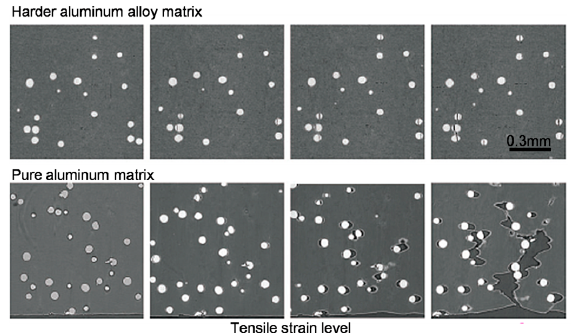
Figure 3. Reconstructed tomographic slices of same region at different strain levels in two model composites (aluminum matrix composites reinforced by 4 vol.% of ZrO 2 /SiO 2 ) observed by in-situ SR- μ CT. The tensile direction is parallel to the horizontal direction. Fracture behavior of composite made of soft pure-aluminum matrix is mainly derived from decohesion along the particle/matrix interface. When hard aluminum alloy matrix is used, the damage of the composite initiate from particle fracture [27].